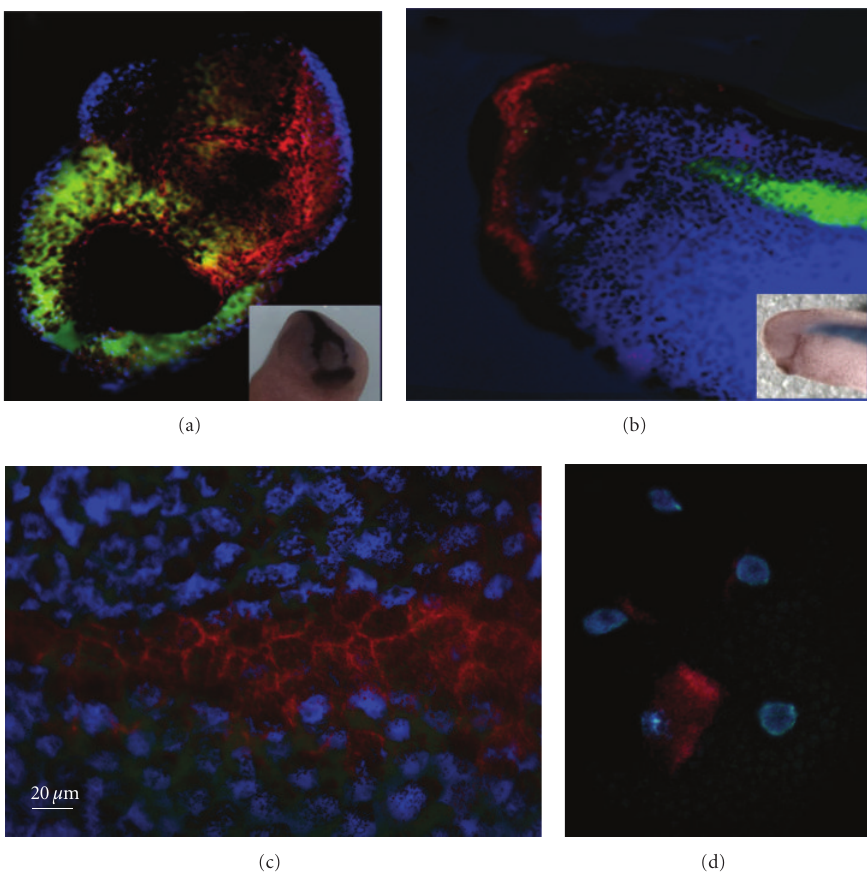
Figure 4: Double whole-mount in situ hybridization against cardiac actin and Xa-1 and the intracellular distribution of LTBP1 and Xa1. (a) A comparison of the staining pattern between the chromogenic and QD-based visualization of the FITC-labeled Xa-1 probe, shown in red, reveals that the QD staining is identical to that obtained using the standard chromogenic protocol. (b) An embryo processed using Biotin and FITC-labeled probes against cardiac actin (green) and Xa-1 (red), respectively. The two probes were visualized with spectrally resolvable QDs demonstrating that two color fluorescent in situs can be performed using QDs. The inset shows the chromogenic staining for cardiac actin for comparison. (c, d) Images of embryos processed for whole-mount in situ hybridization and counterstained with Hoechst (blue) at 20X (c) and 40X (d) magnification, showing di ff erences in the intracellular distribution of the transcripts of Xa-1 (c) and LTBP1 (d), both shown in